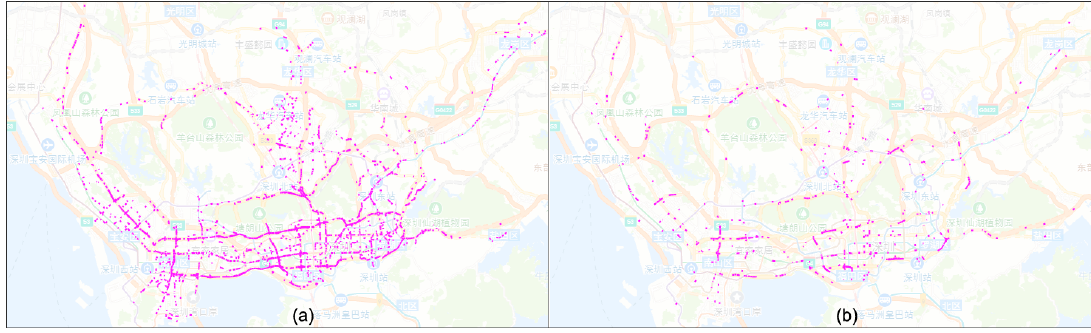
Figure 8. Spatial distributions of links during traffic rush hours. Similarity is ( a ) the morning rush hour and ( b ) the evening rush hour.